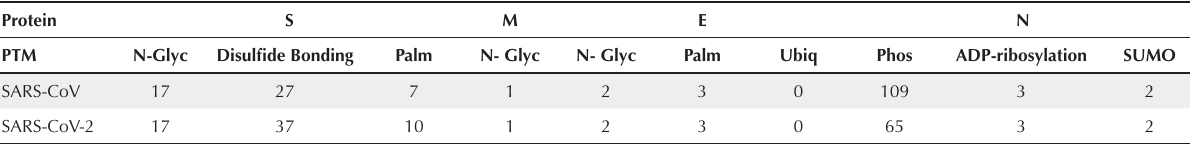
Table 2 . PTMs of S, E, M, and N proteins of SARS-CoV and SARS-CoV-2 Protein S M